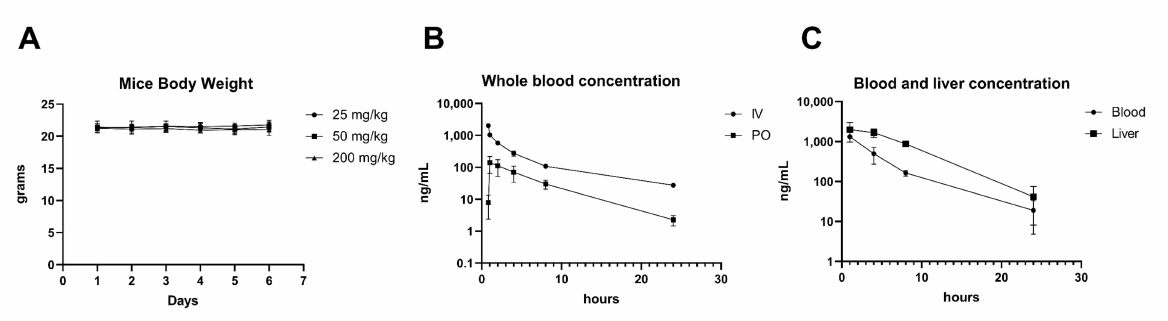
Figure 3. NV651 effect on body weight and PK analysis. ( A ) Mice body weight changes during the NV651 treatment in BALB/c nude mice, n = 5 mice per group. ( B ) NV651 concentration in the blood after an intravenous injection (0.5 mg/kg) or oral dosing (5 mg/kg) in CD1 mice, n = 3 mice per group. ( C ) NV651 concentration in the blood and liver after a 10-mg/kg administration PO in CD1 mice, n = 3 mice per group and time